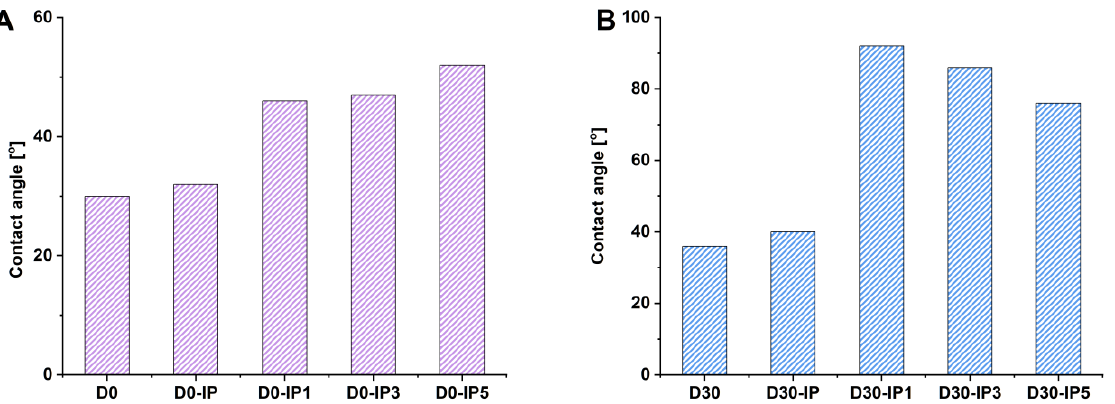
Figure 7. Water contact angles of the developed TFC and TFN membranes with ChS ( A ) and Fe- ChS ( B ) BTC-ChS ( B ) interlayers.